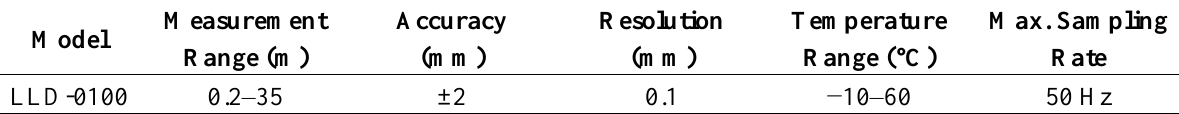
Table 1. Specifications of the LDS.